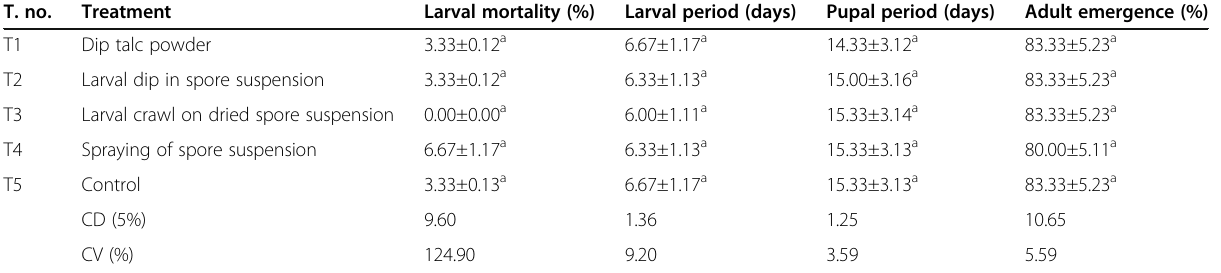
Table 7 Effect of Lecanicillium lecanii on some biological parameters of Oligotapygmaea T. no.